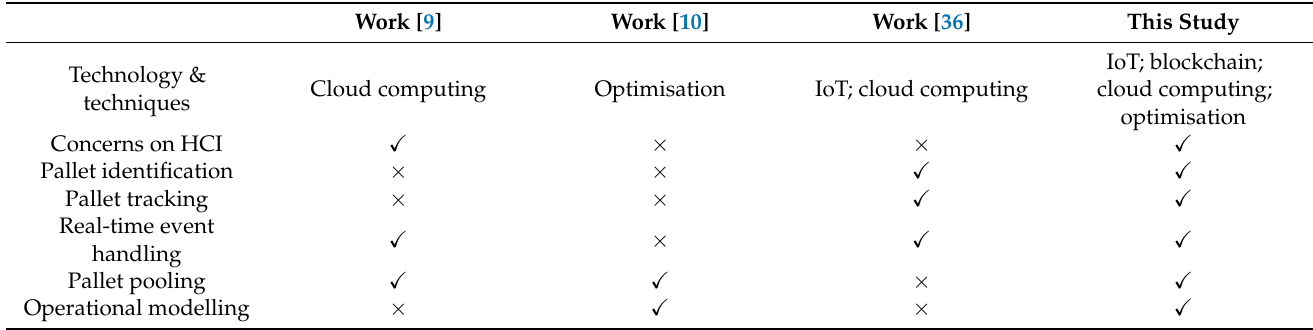
Table 2. Comparison with existing pallet management